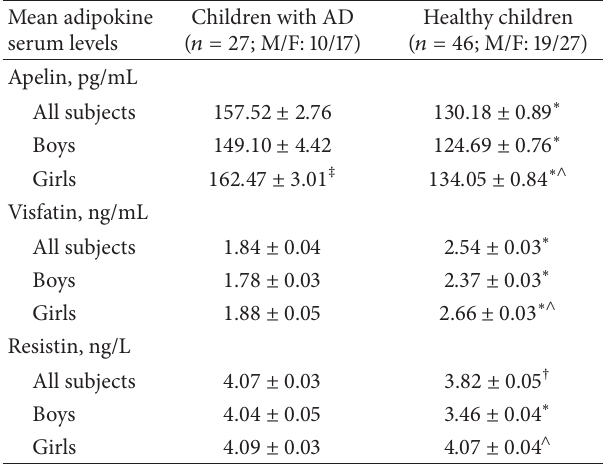
Table 1: Demographic and clinical characteristics of children with atopic dermatitis and healthy children.